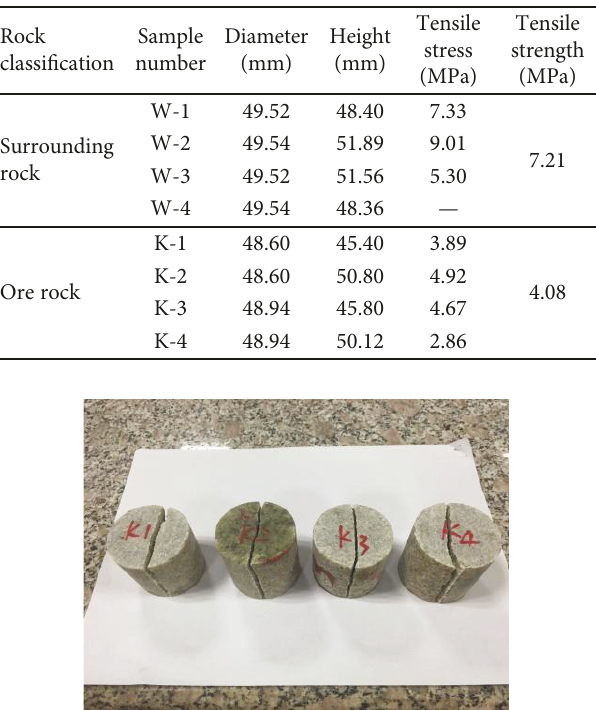
Table 3: Angle-moulded shear specimen parameters and test results.